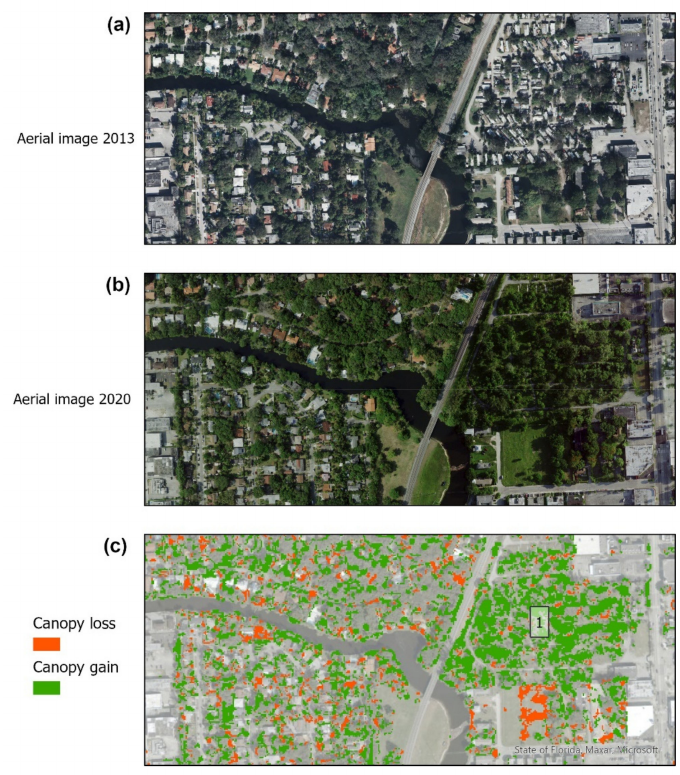
Figure 4. Tree canopy gain in El Portal through reforestation of a former mobile home park area: ( a ) Mobile home park present (2013); ( b ) Mobile home park removed (2020); ( c ) Tree canopy gain in reforested area (background map credits: State of Florida, Maxar, Microsoft).